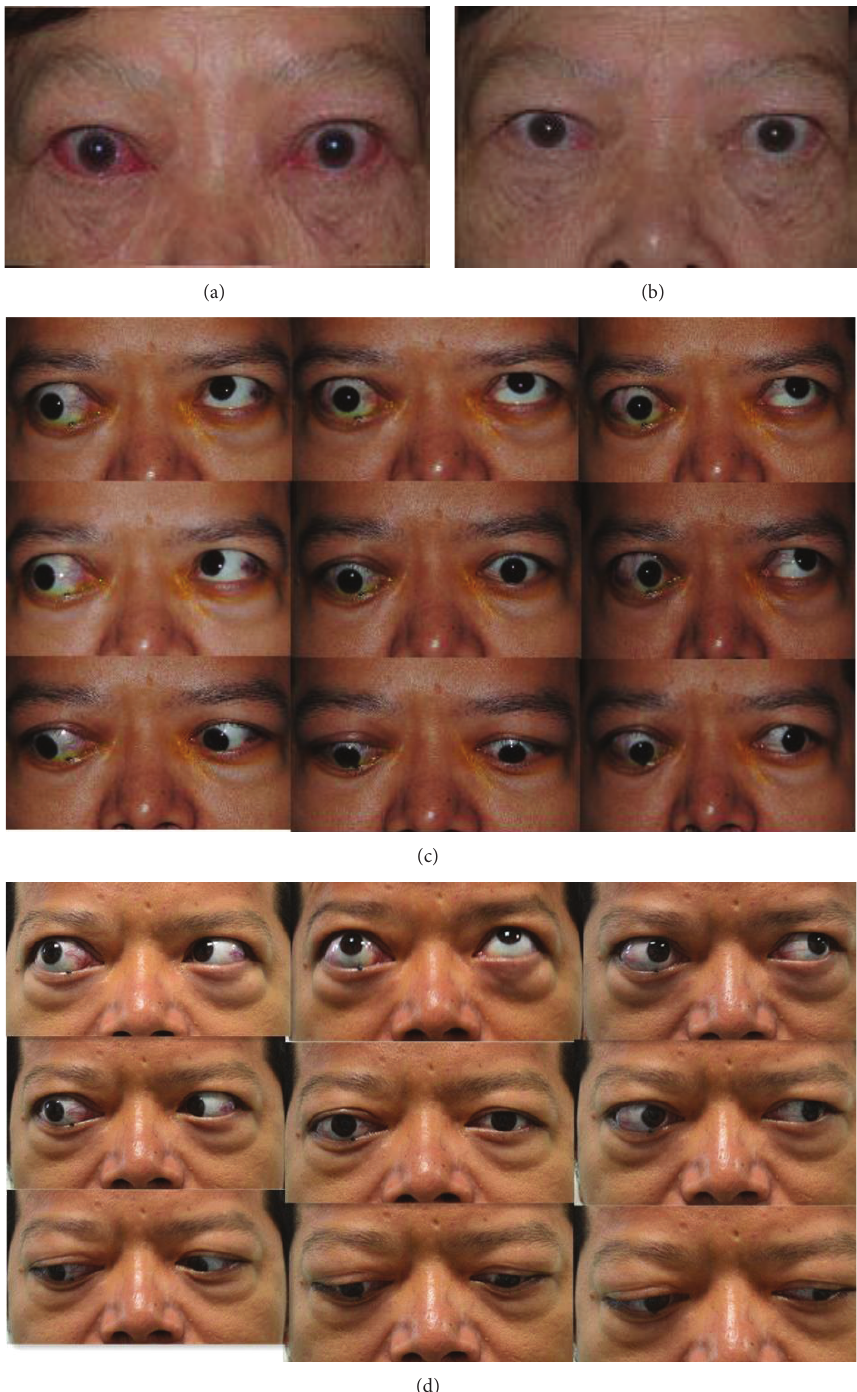
Figure 1: Representative example of patients status at baseline and at 24 wk after the start of treatment. (a) (baseline) and (b) (24wk) showed that soft tissue involvements and redness of conjunctiva were remarkably improved in a female at 24wk. (c) (baseline) and (d) (24 wk) showed the improvement of eyelid aperture, lid lag, and elevation in a male treated by